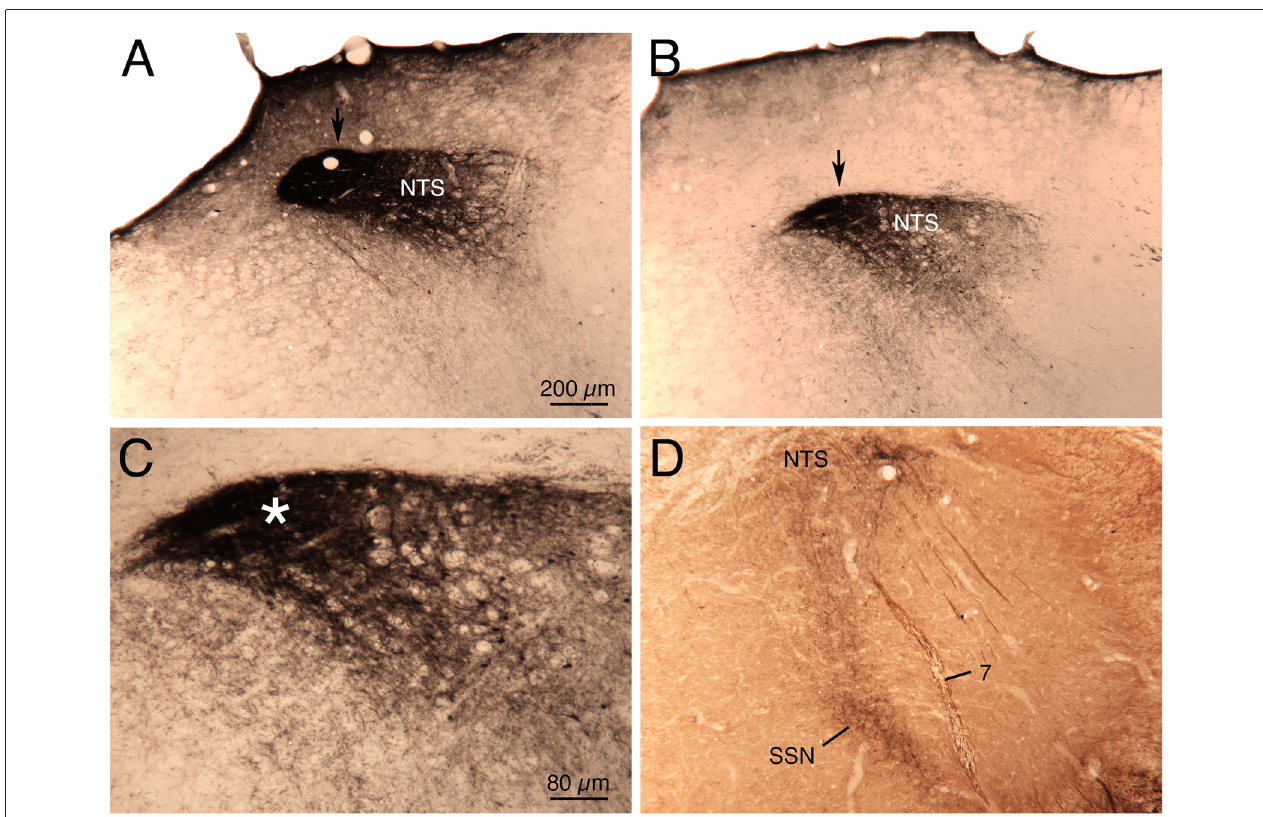
FIGURE 5 | Images showing the course of the axons from baroreceptive NTS coursing to prechoroidal SSN, as visualized in a previously described case (Li et al., 2010, 2015) in which biotinylated dextran amine was injected into NTS just anterior to the AP. Images (A,B,D) show increasingly rostral levels through NTS, and the NTS axons are indicated by an arrow in (A,B) . Higher magnification view of the axons shown in image (B) is shown in image ( C ; asterisk). In image (D) , two-color DAB labeling has been performed to simultaneously detect the neurons (brown) of choroidal SSN for their enrichment in neuronal nitric oxide (NO) synthase, and the axons (black) coursing from NTS to the SSN. The magnification is the same in (A,B,D) .